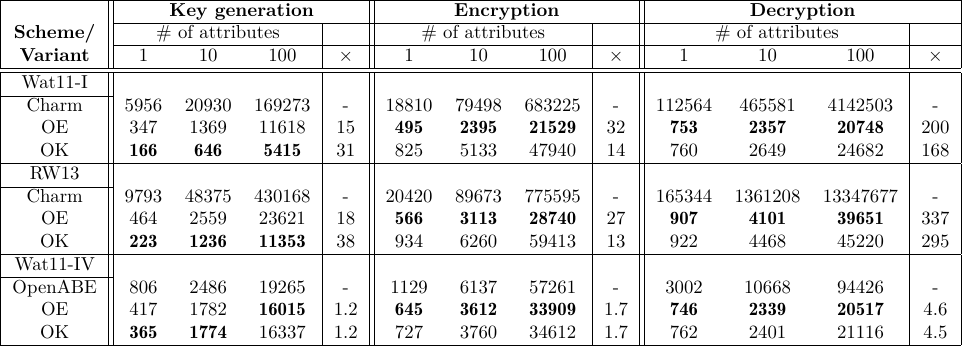
Table 7: Comparison of the computational costs of the Charm and OpenABE implemen- tations of Wat11 and RW13, and our implementations, on the BN254 curve. For the costs with 100 attributes, we also provide the factor ( × ) by which the costs are lower than the least efficient variant of the scheme. For each scheme, the lowest costs are typeset in bold . Table 7b expresses the costs in milliseconds (for a processor with a frequency of 4.1